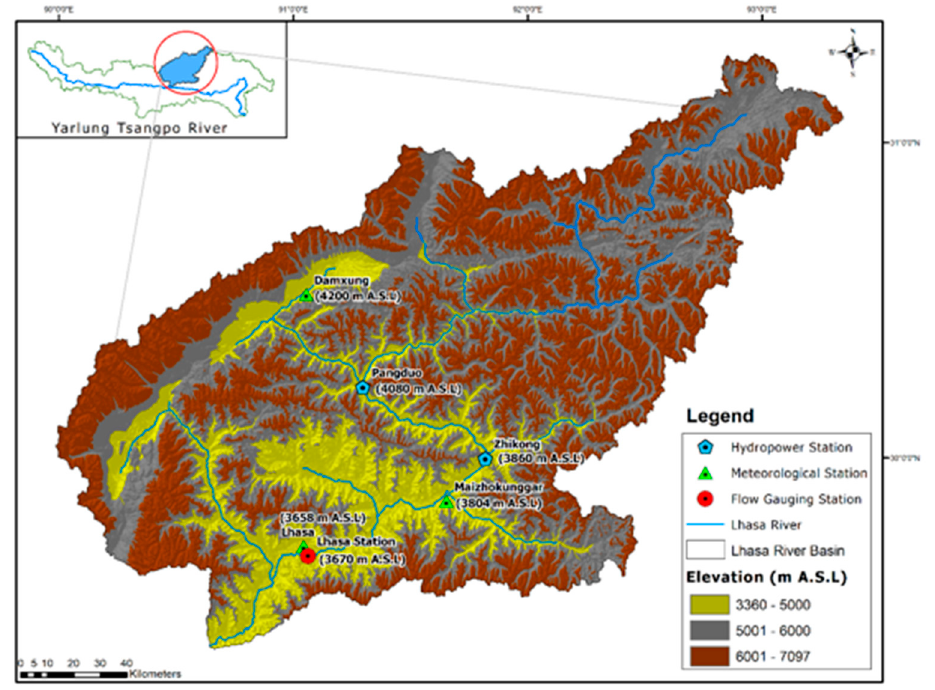
Figure 1. Location map of the Lhasa River Basin extracted from the Advanced Thermal Emission and Reflection Radiometer, Global Digital Elevation Model (ASTER GDEM) dataset showing hydrological and meteorological stations, hydropower plants, and some other features of the study